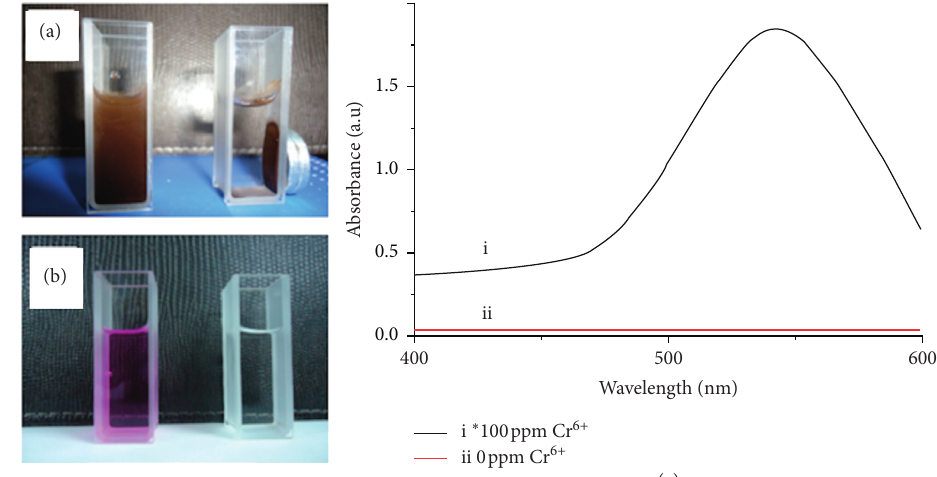
3 O 4 @SiO 2 @LEuH@PW 10 .